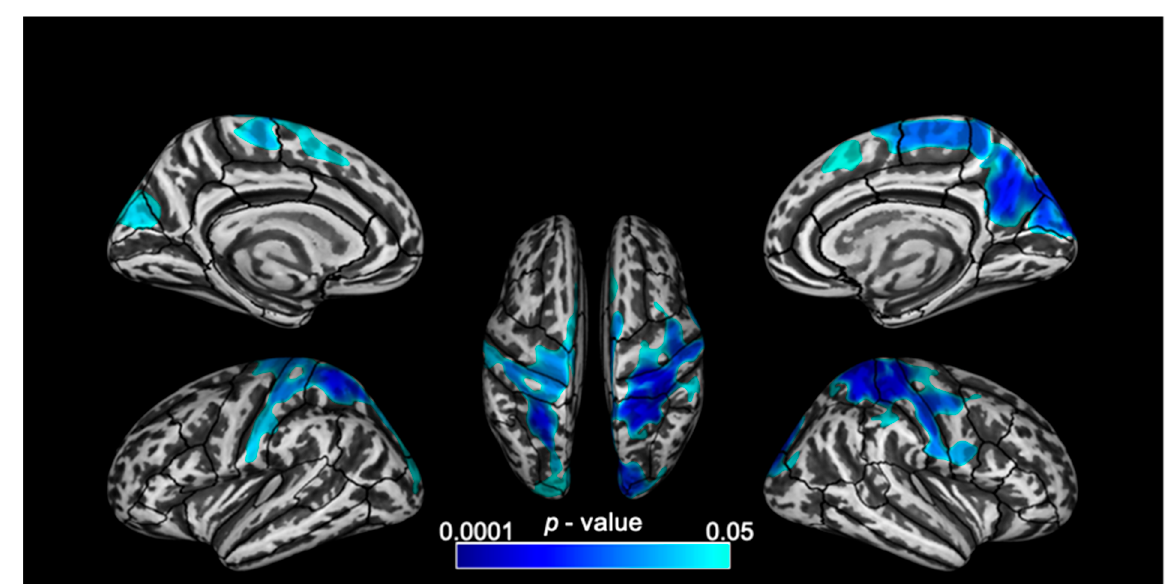
Figure 2. Lateral, medial and superior views of the brain with clusters of significant ( p < 0.05, corrected for multiple comparisons) negative correlation between cortical thickness and EXE scores (from the Attention Network Tests-Interaction) overlaid on inflated surfaces. Table 3. Cortical regions and the number of vertices that show significant ( p < 0.05, corrected for multiple comparisons) negative correlation between EXE scores and cortical thickness in MS.